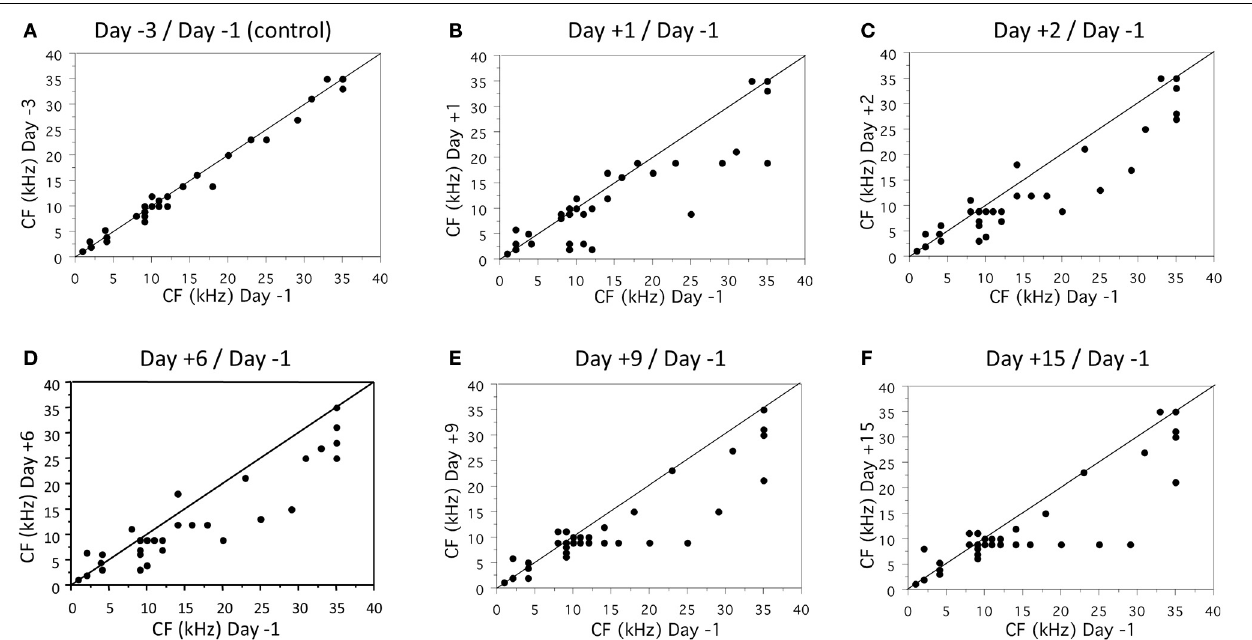
FIGURE 2 | Time course of Characteristic Frequency shifts from 1 day to 15 days after the trauma. Each scatterplots represent the Characteristic Frequency (CF) of the recorded neurons on the day of interest (y-axis) against a control value computed the day before the trauma (x-axis). The day of